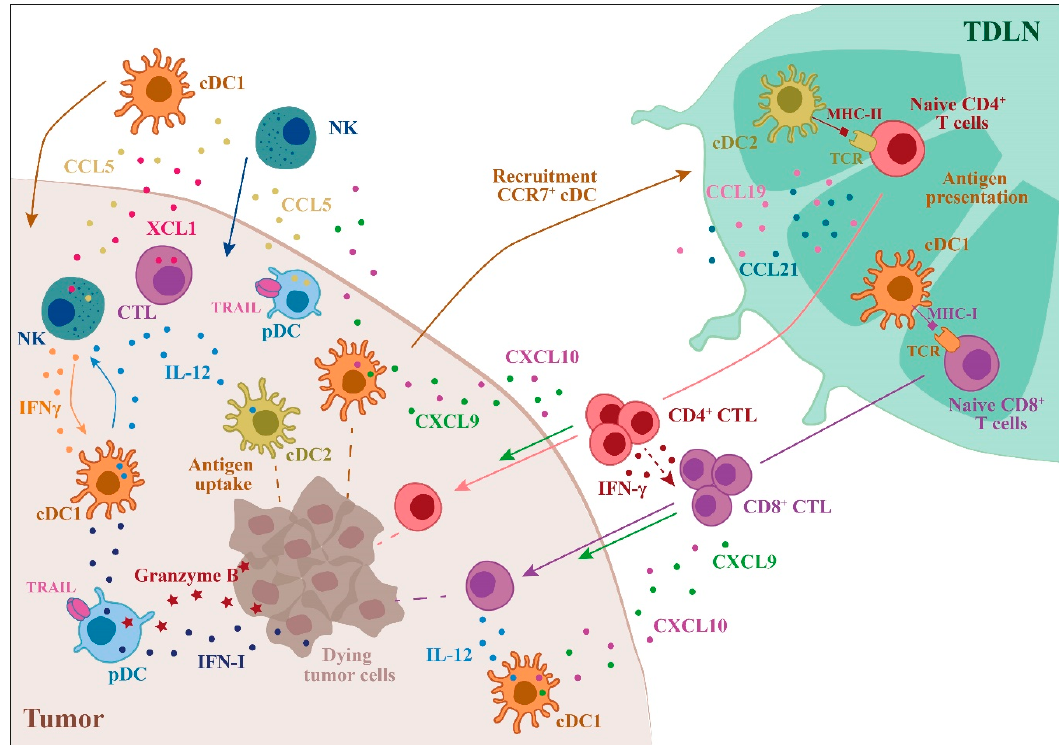
Figure 1. Role of dendritic cells (DC) subsets in the regulation of the anti-tumor immune